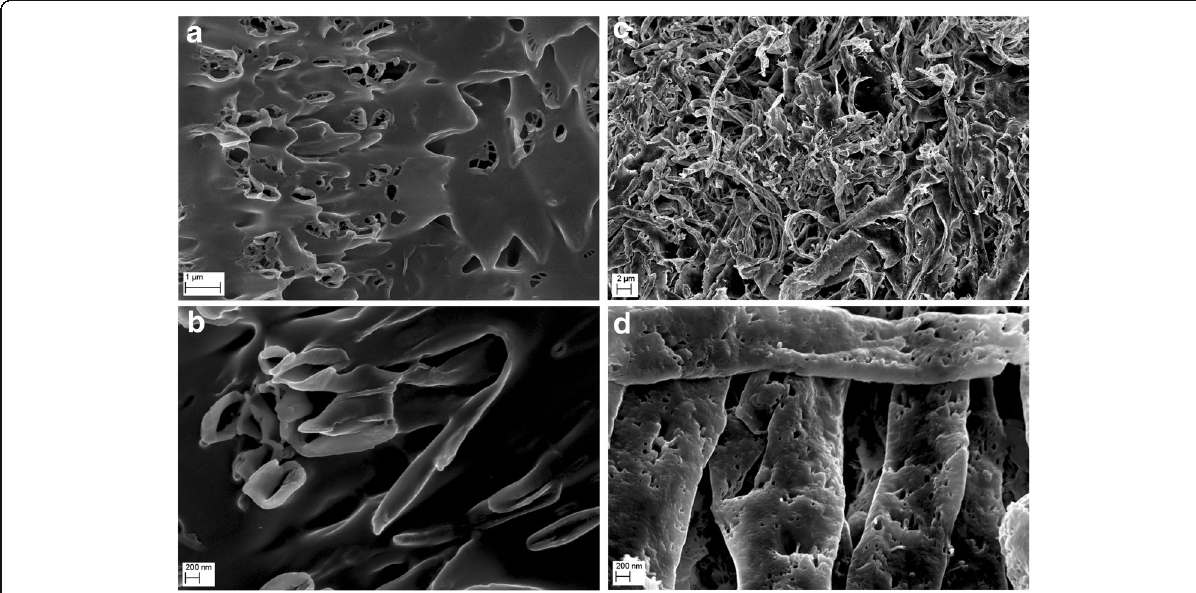
Fig. 6 Comparison of morphology of lyophilized Ag-NP mixture ( a , b ) and Ag-NP mixture after ultrasonic treatment ( c , d ) using scanning electron